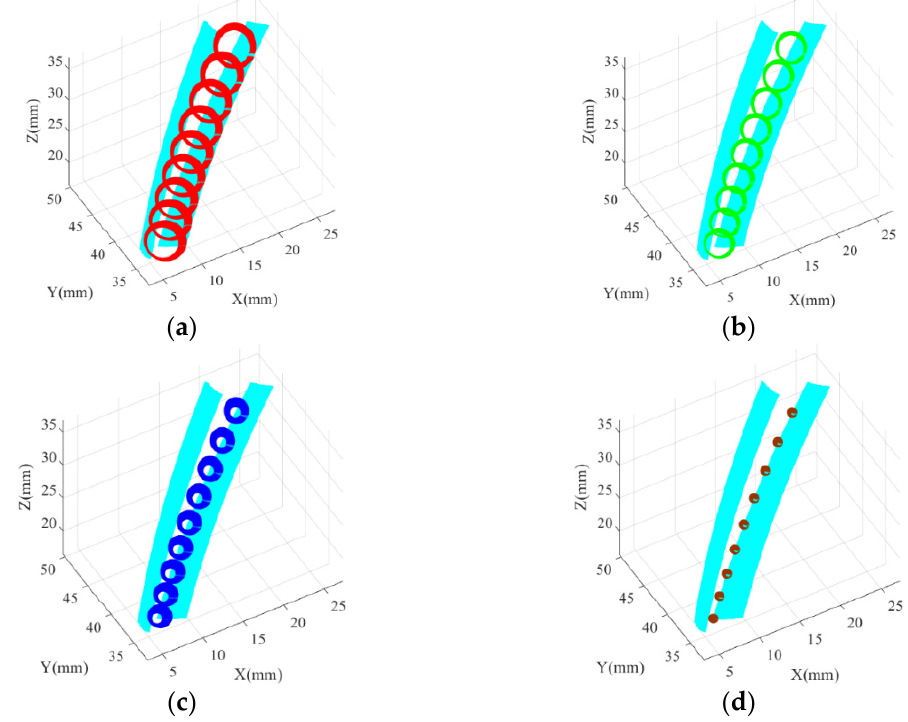
Figure 12. Machining simulation: ( a ) Machining the convex tooth surface; ( b ) Machining the transi- tion tooth surface; ( c ) Machining the concave tooth surface; ( d ) Machining the root tooth surface.